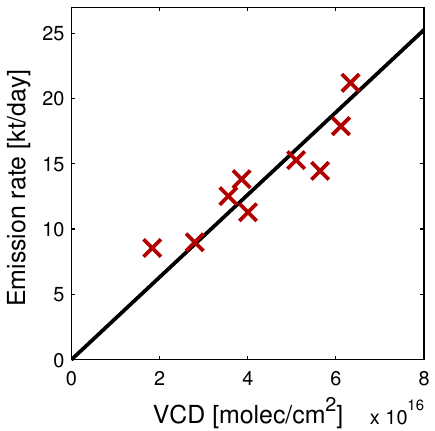
Figure 6. Fitted monthly mean SO 2 emission rates vs. the respec- tive mean SO 2 VCD (averaged over 17–20 ◦ N, 155–160 ◦ W) for March–November 2008. The correlation coefficient is R = 0 . 92. The black line represents a linear fit forced through origin.